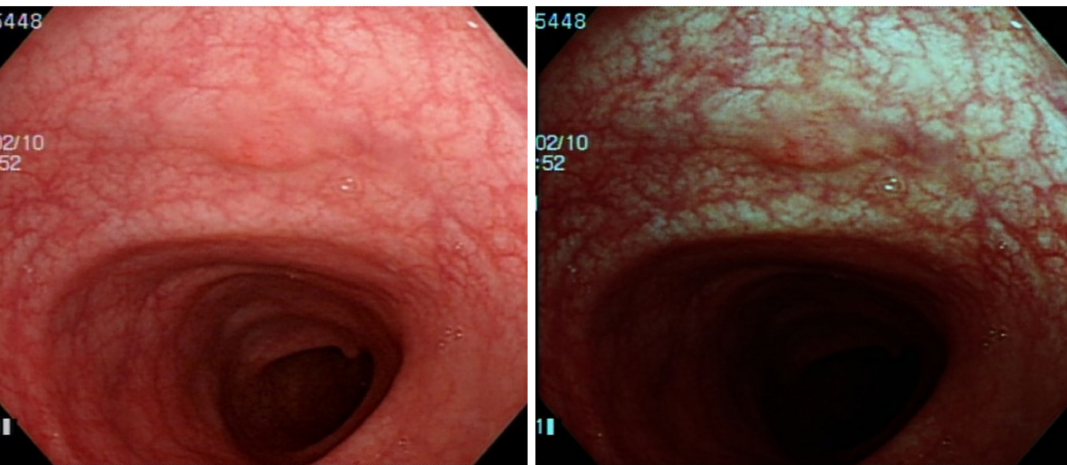
Figure 9. Image of SSA polyp after gamma and sigmoid conversion. (( Left ): Original WL, ( Right ): Gamma and Sigmoid